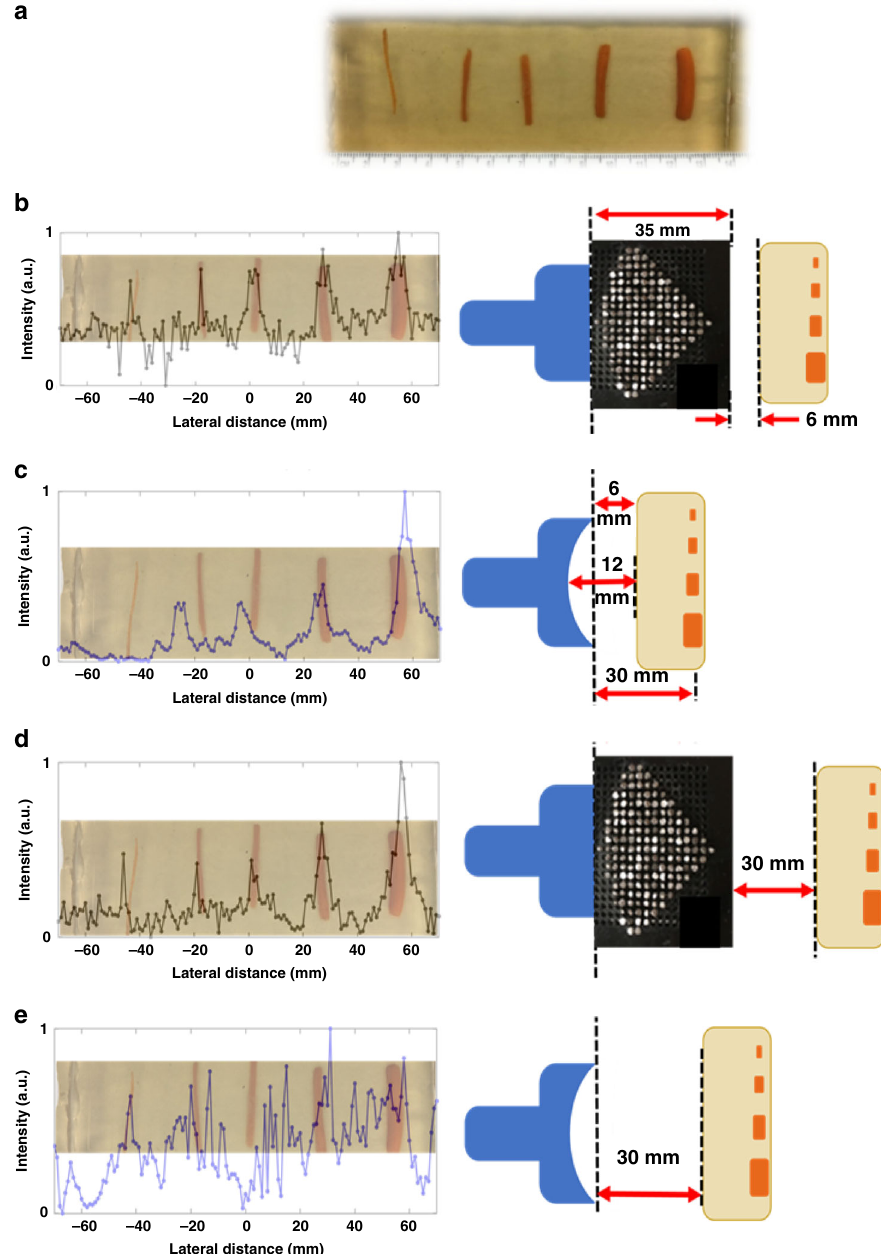
Fig. 7 Comparison between a focused transducer and the ML both at and beyond the focal zone. a Samples of carrot tissue ranging from 1.5 mm (left) to 6 mm (right) in width. Scan with carrot tissue at the focal length of the focused transducer for the ML ( b ) and focused transducer ( c ). Scan with carrot tissue in the Fresnel transition zone of the unfocused transducer for the ML ( d ) and focused transducer ( e ). Comparative acuity of ML vs. focused transducer at ( b , c ) and beyond ( d , e ) the transducer focal length. Scans were performed monostatically with carrots at average depth of 15 mm in the